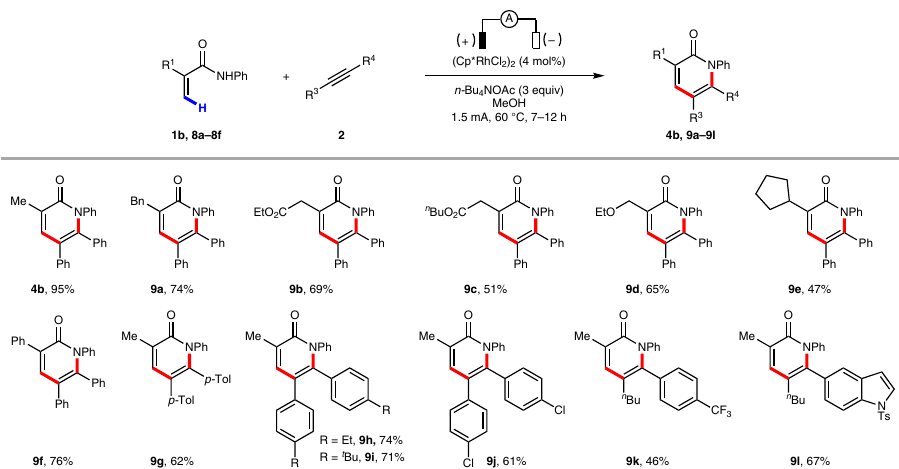
Fig. 3 Scope of α -pyridones. Isolated yields are reported. Reaction conditions: 1b or 8 (0.3 mmol), 2 (0.2 mmol), (Cp*RhCl 2 ) 2 (4 mol%), n -Bu 4 NOAc (3.0 equiv.) and MeOH (3 mL), in an undivided cell with two platinum electrodes (each 1.0 × 1.0 cm 2 ), 60 °C, 1.5 mA, 7 – 12 h.